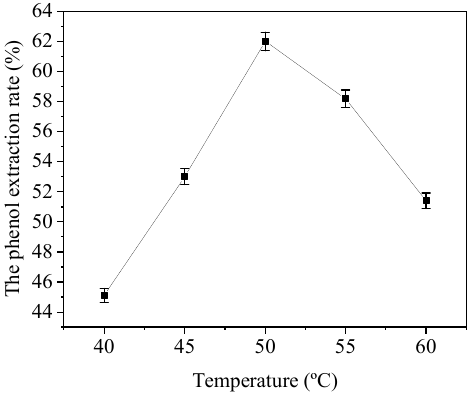
Figure 11. Effect of reaction temperature on phenol extraction rate.